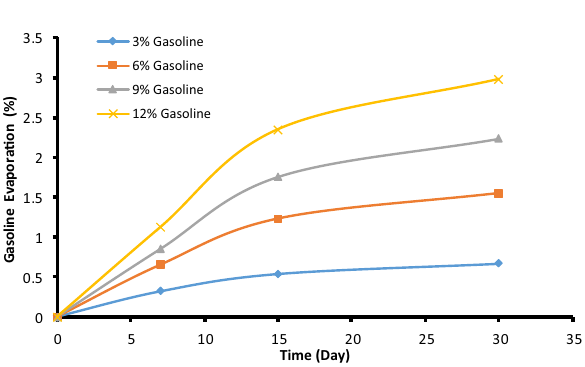
Table 5 Properties of the gasoline used in this study Dynamic viscosity at